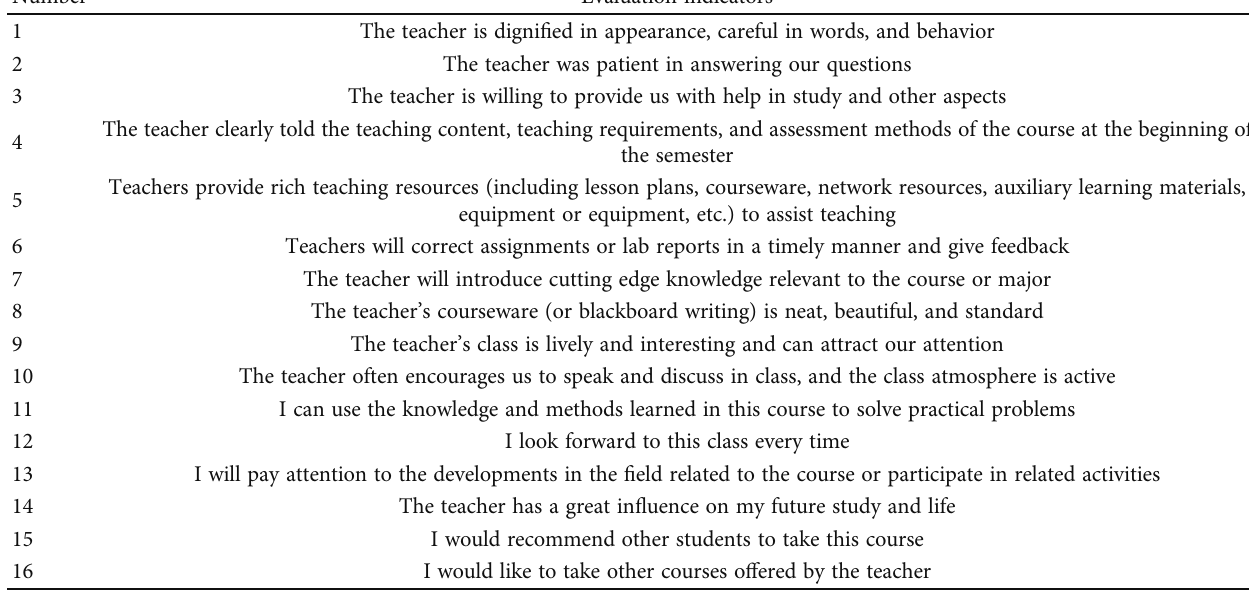
Table 1: Undergraduate teaching evaluation indicators (general courses).